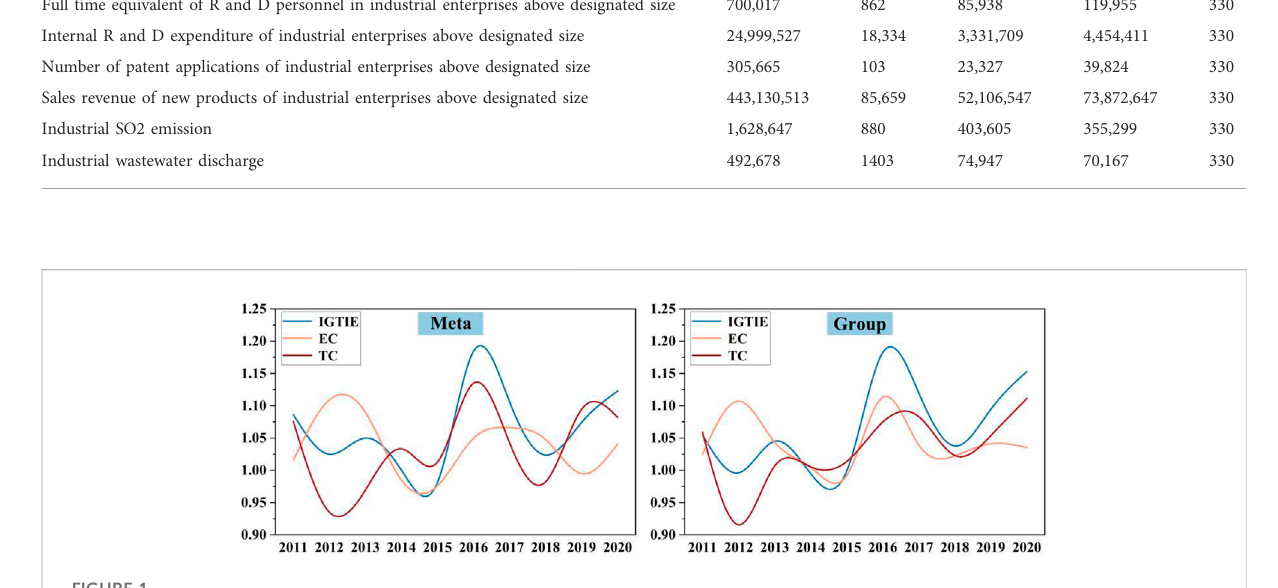
FIGURE 1 China ’ s IGTIE and its decomposition indexes during 2010 –